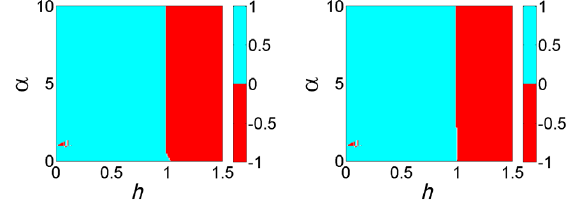
FIG. 5. Numeric results of differential local convertibility for the ferromagnetic (symmetry broken). Left: A partition 200 ¼ 2 j 198 . Right: 200 ¼ 50 j 100 j 50